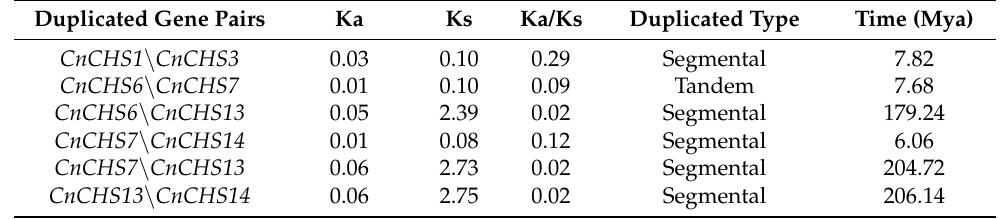
Table 1. Calculation of Ka, Ks, and Ka/Ks and the time of divergence of CnCHS gene pairs. Duplicated Gene